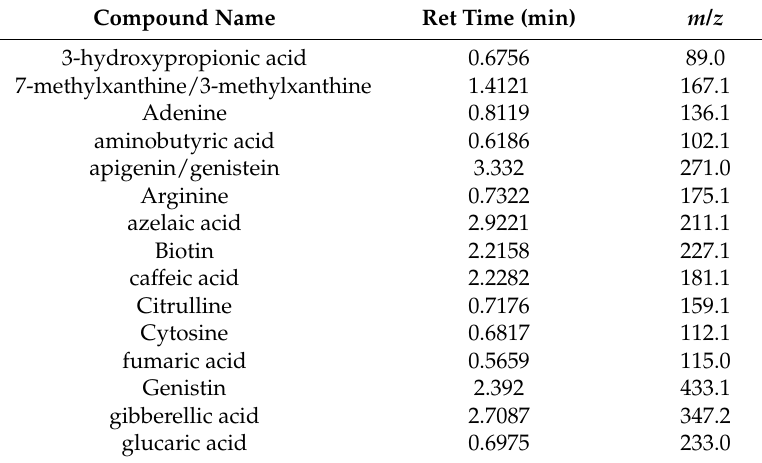
Table 2. LC/MS analysis of MxG